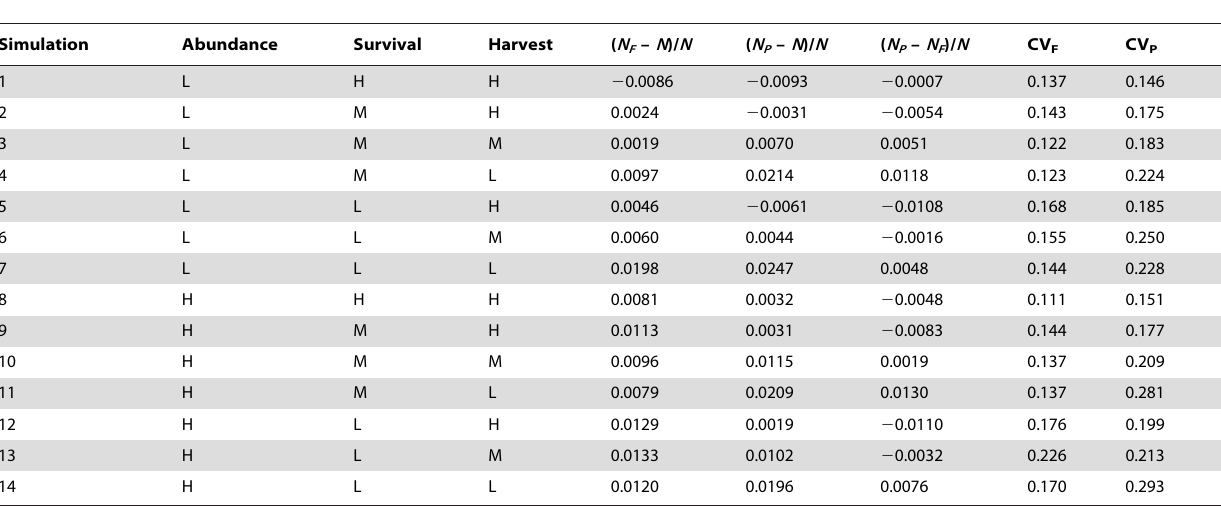
Table 1. Simulation results* for pooled adult age-class and full age-class population reconstructions with an average percent bias of abundance estimates from the pooled age class analysis ( N P ), the relative bias for the full age-class analyses ( N F ), average relative difference between estimation techniques, and average coefficient of variation (CV) for the two approaches.